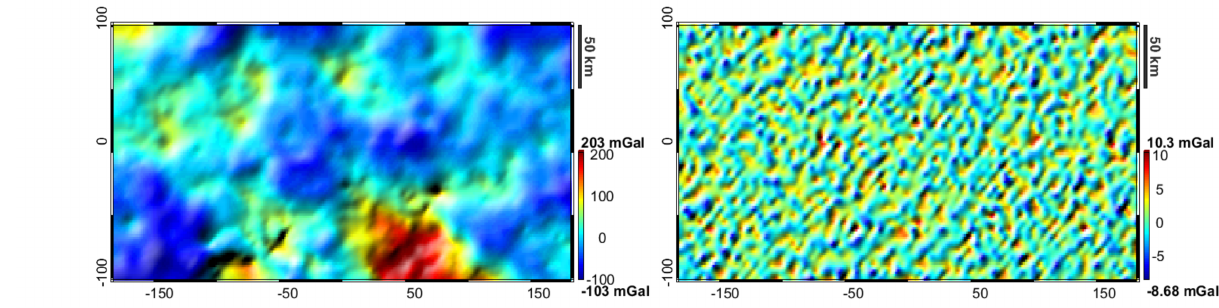
Figure 2. Gravitational effect of the synthetic model ( left ), and simulated observation error ( right ).